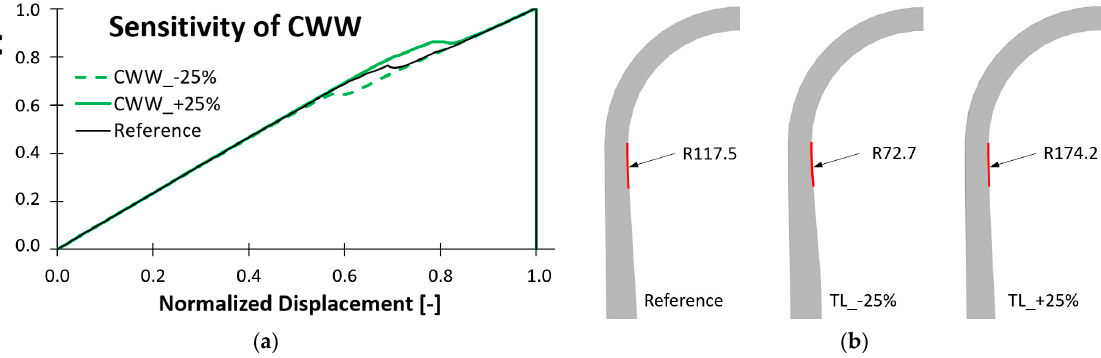
Figure 13. ( a ) Influence of CWW variations on the load-displacement-curve of a meso-model; ( b ) Notch shapes resulting from TL variations.